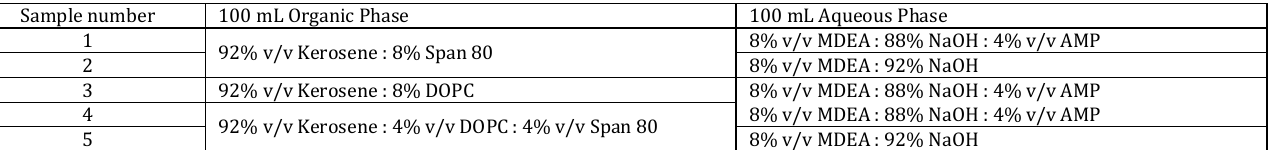
Table 1: Formulation and condition used during emulsion preparation for different concentration of cosurfactant.